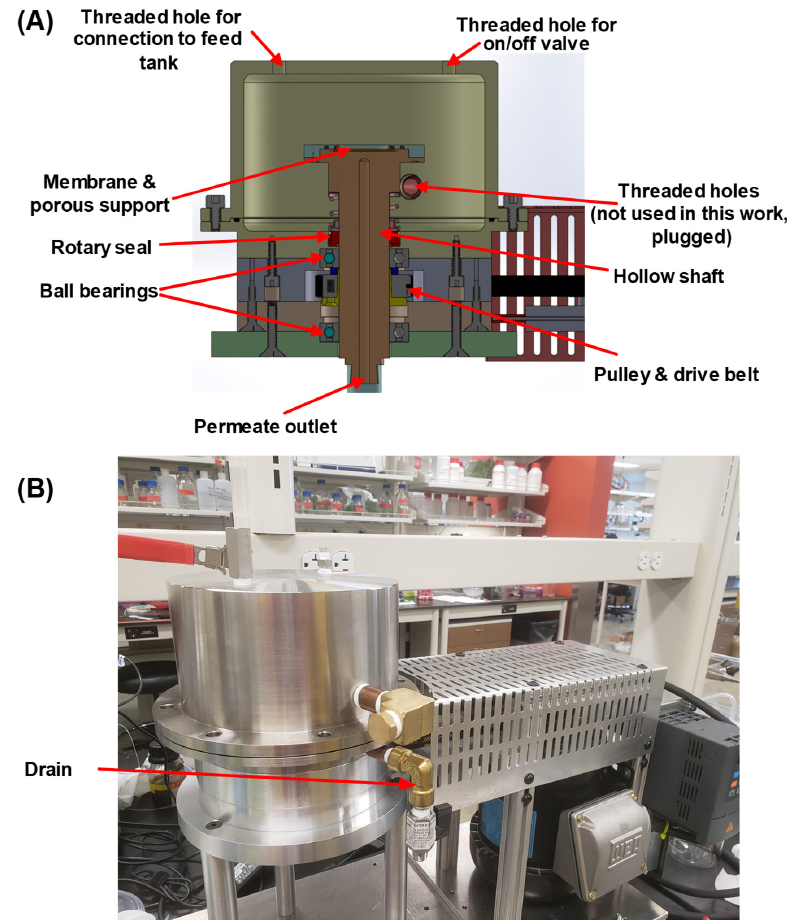
Figure 3. ( A ) Schematic diagram of the rotating-membrane filtration unit. The drain is not drawn in ( A ) but is shown in the photograph of the test unit ( B ).